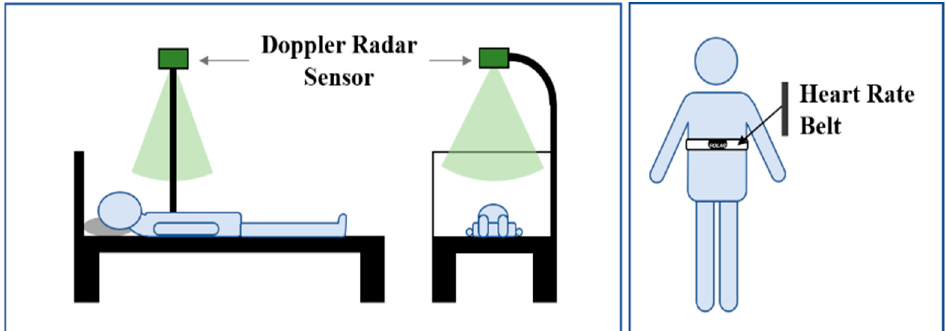
Figure 7. The setup for sleeping and illustration of heartrate belt.